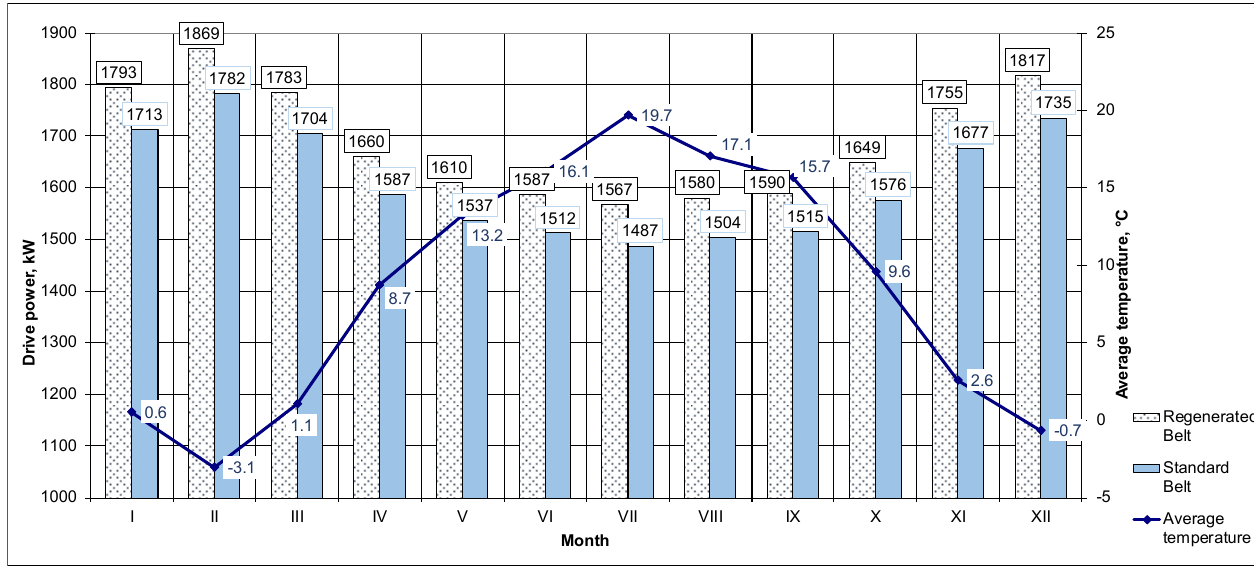
Figure 5. Relationship between power consumption and mean monthly temperatures for the 1-ST standard belt and for the 4-EO energy-saving belt.